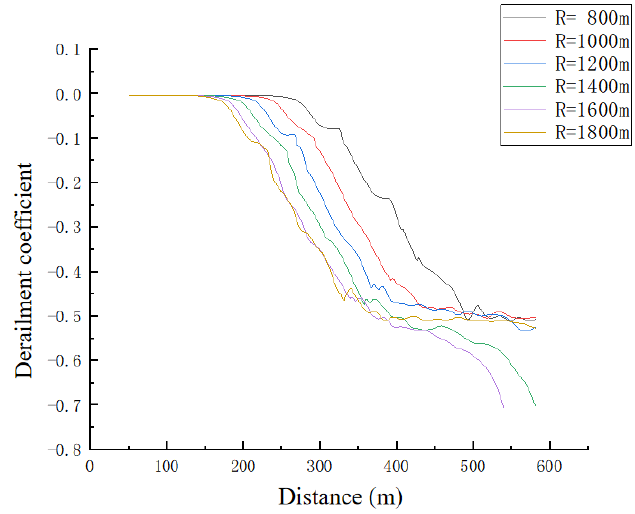
Figure 15. Variation of derailment coefficient at critical derailment speed.